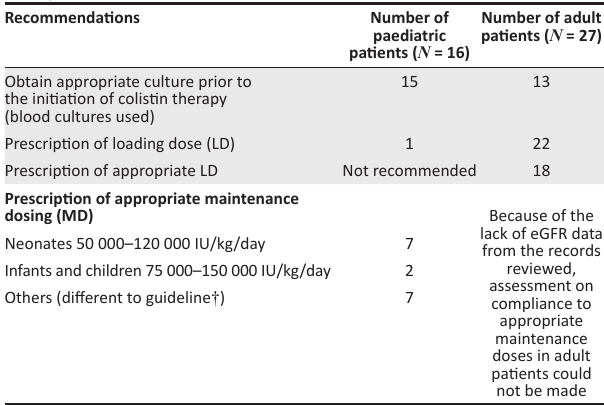
TABLE 3: Additional antibiotics sensitive to isolated organisms in adults and paediatrics. Additional antibiotics sensitive to isolated organism (possible alternative antibiotic to colistin) ( N = 27)